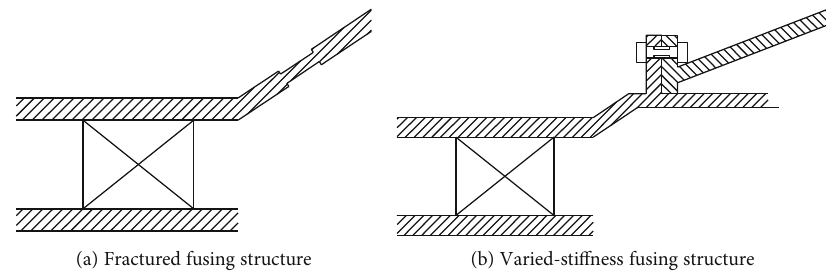
Figure 11: Fusing structure.